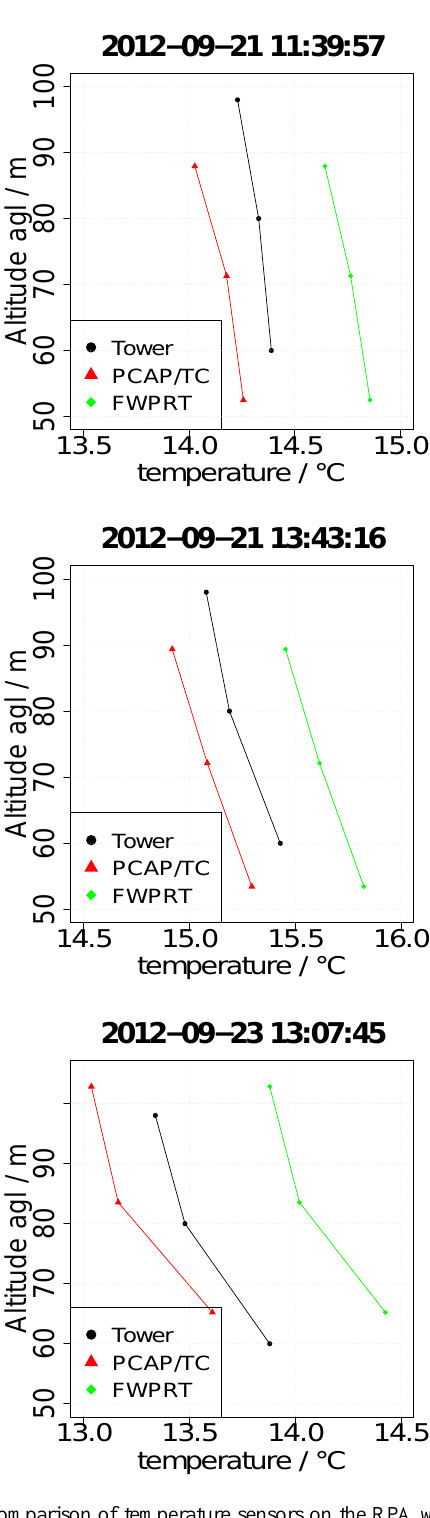
Fig. 8. Comparison of temperature sensors on the RPA with tower data, 10min averages at three levels and three different